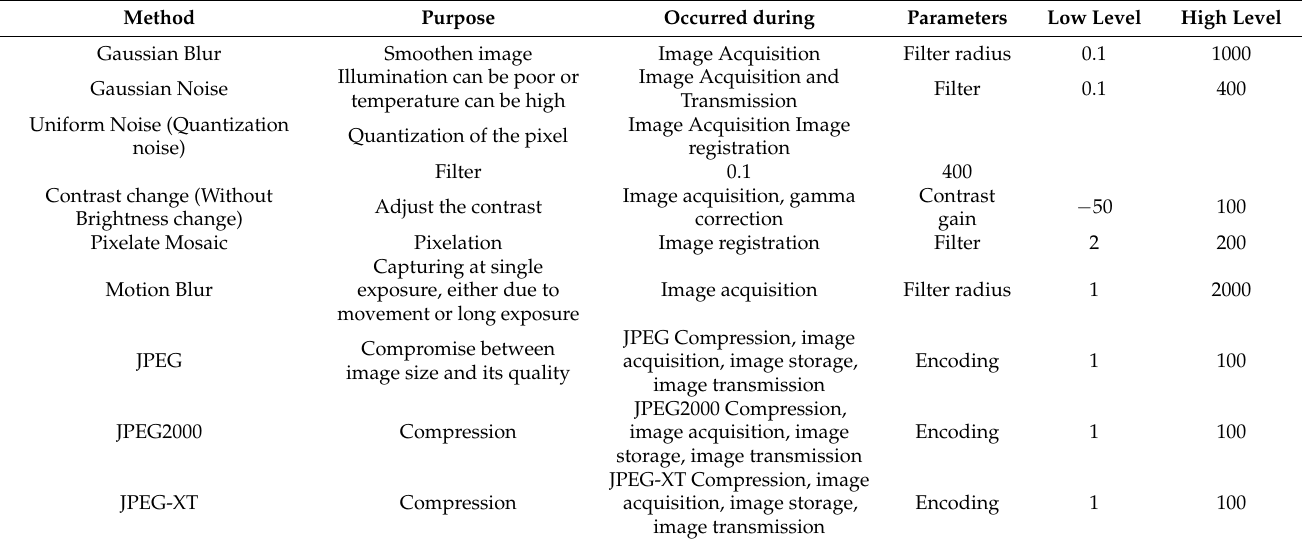
Table 4. Details of the used distortions in NITS-IQA